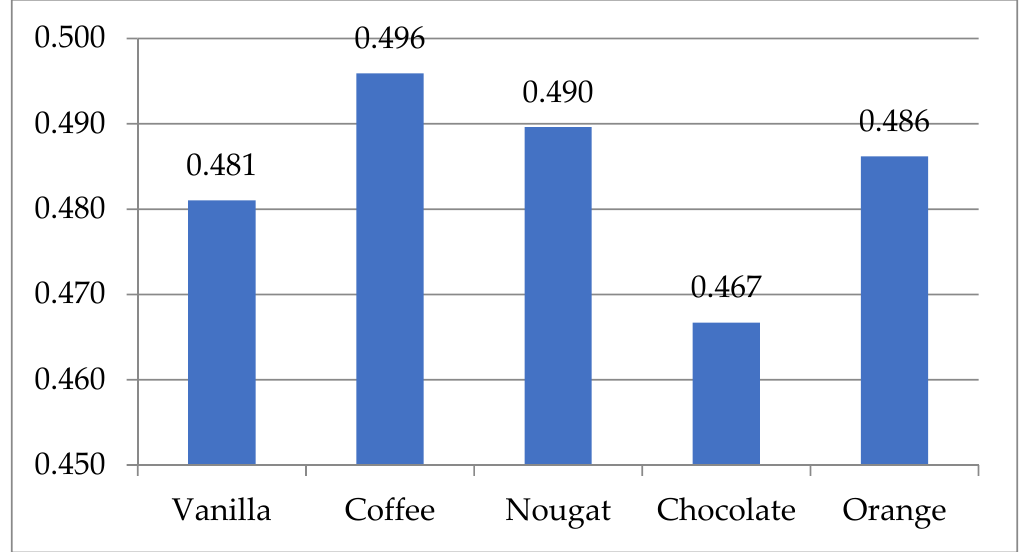
Figure 7. Frustration scores in measuring the impact of the aromas on emotional response.